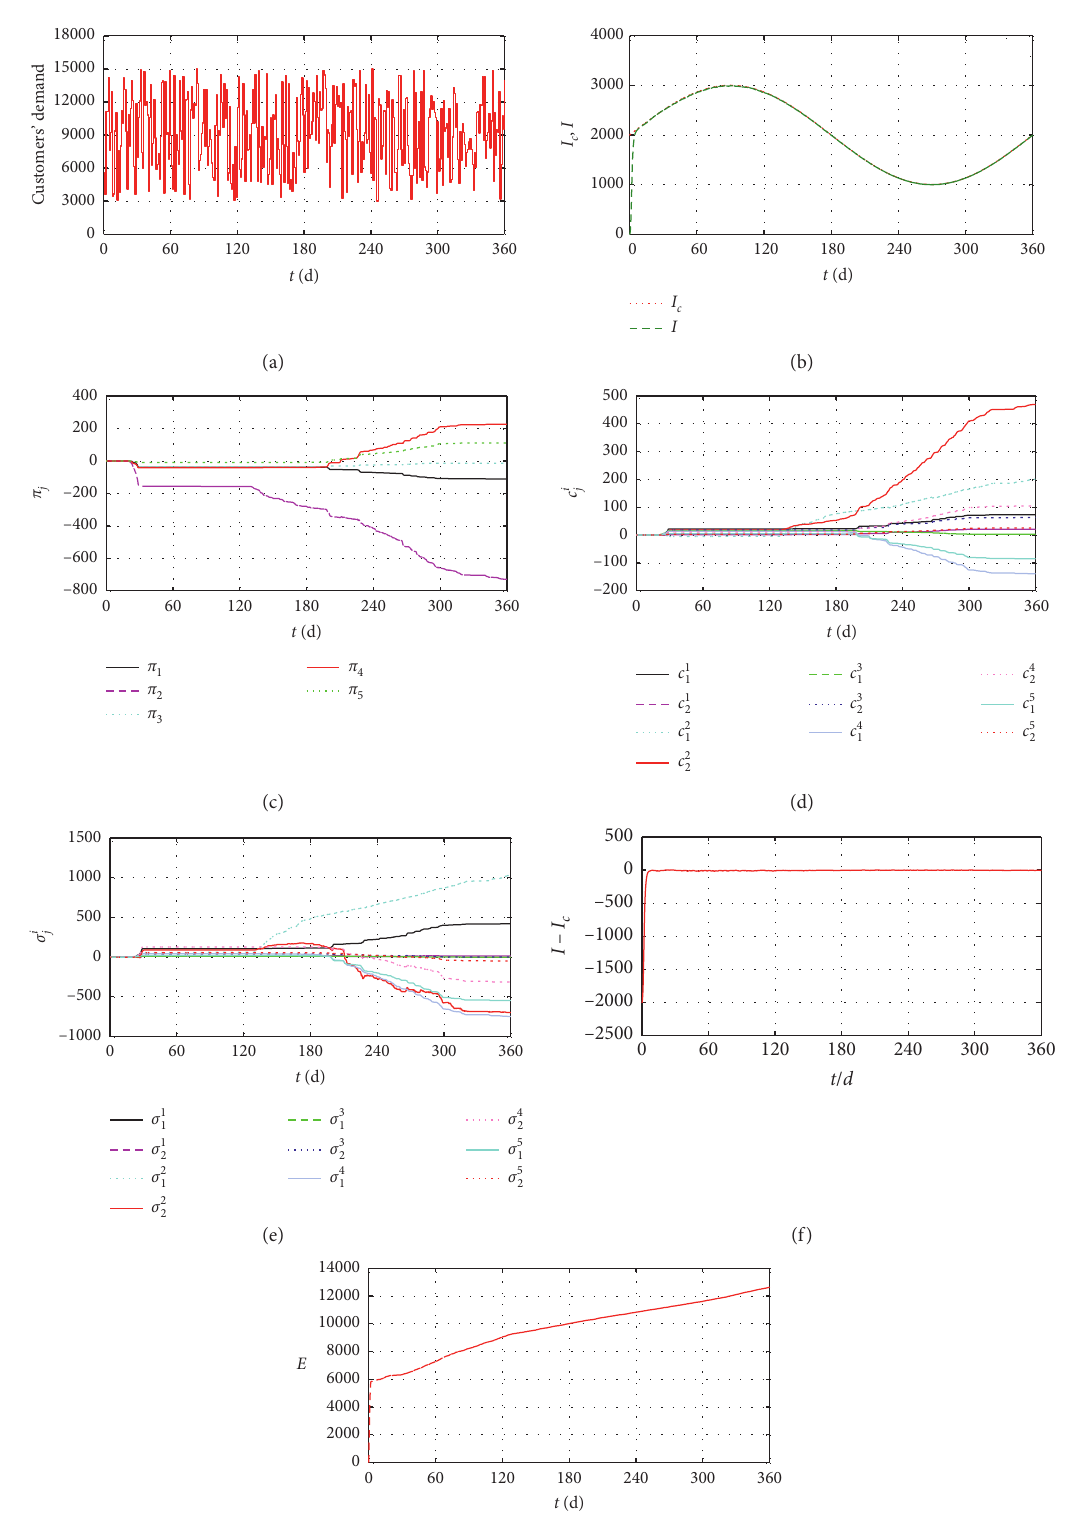
Figure 5: Simulation results under random demand. (a) Customers’ demand. (b) Inventory curves. (c) Curves of adaptive parameter π (d) Curves of adaptive parameter c i j . (e) Curves of adaptive parameter σ i j . (f) Error curve of I − I c . (g) Curve of E